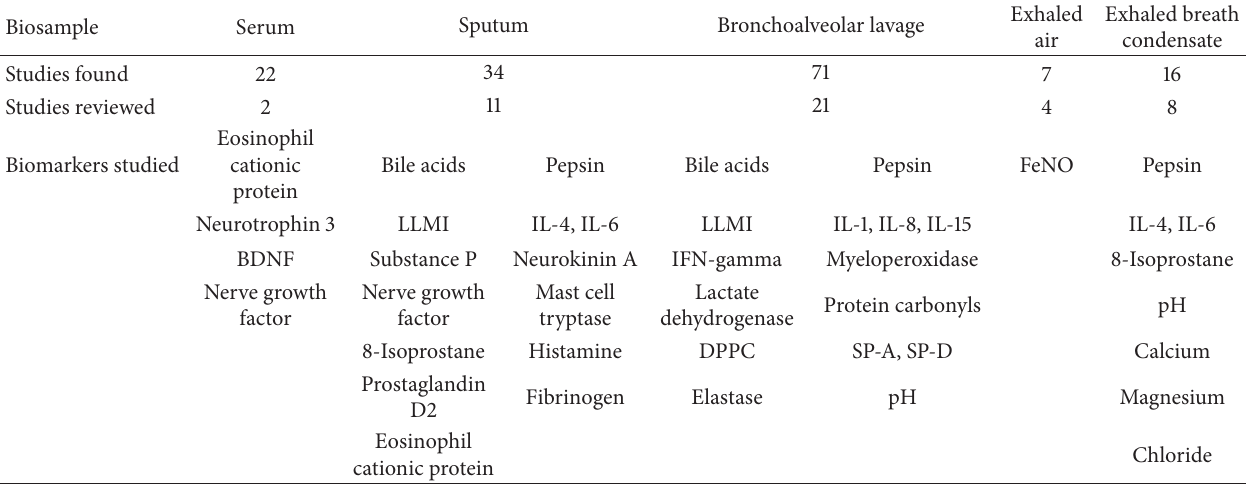
Table 1: Biomarkers studied in gastroesophageal reflux with respiratory